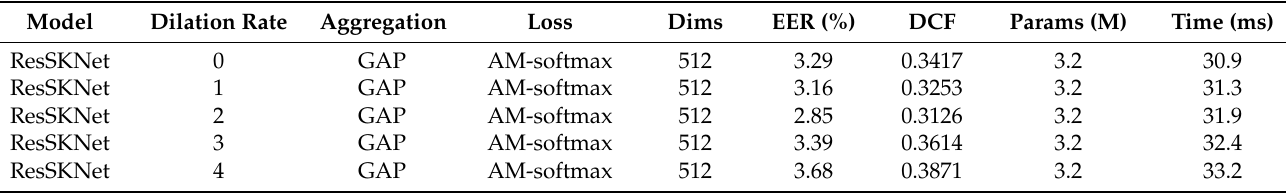
Table 3. Results of dilation rate on